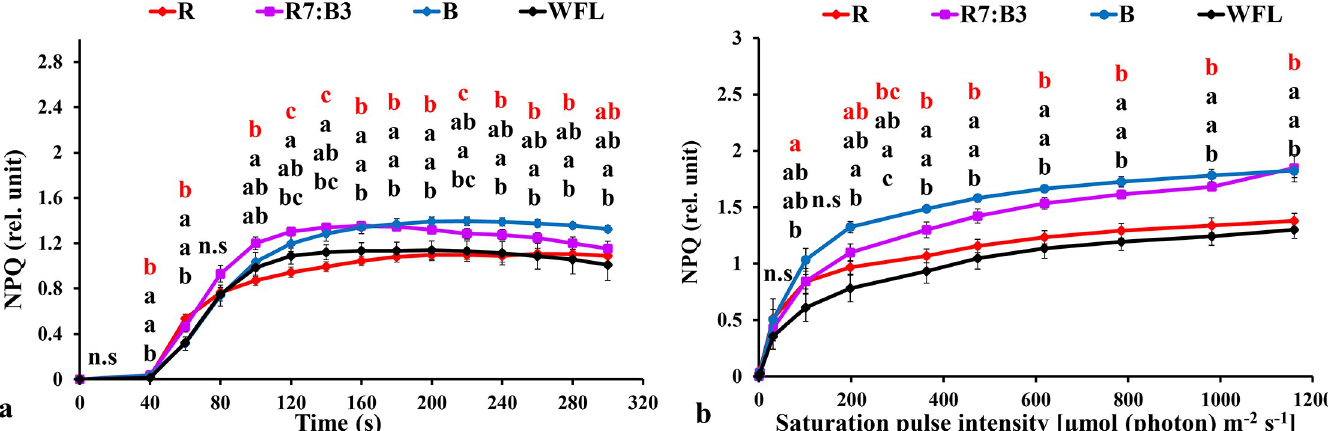
Fig 4. Effect of LED light quality on chlorophyll a fluorescence induction kinetics of dark-acclimated ( a ) and RLC of the light-acclimated ( b ) non-photochemical quenching (NPQ) in grafted tomato leaves. Similar letters indicate non-significant difference among treatments according to DMRT at P � 0.05. Vertical bars indicate average ± standard error (4 replicates). According to the treatments, sort significance letters from top to bottom (R, R7:B3, B, WFL). Where R = Red light 100%, R7: B3 = Red70%+ Blue30%, B = Blue light 100%, WFL = White Fluorescent Lamps100%.